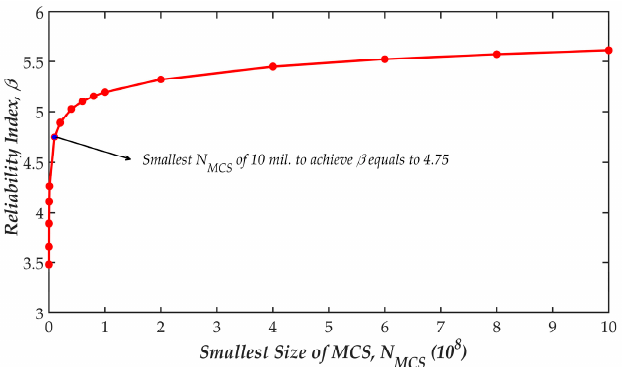
Figure 6. Relationship between the smallest number of simulations and the expected reliability index in MCS.